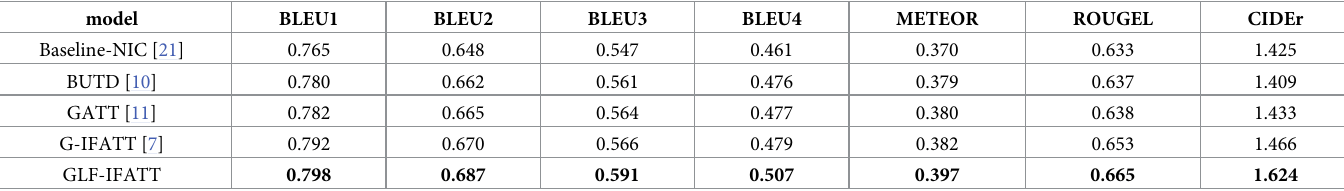
Table 2. Evaluation scores of comparison experiment with other models.